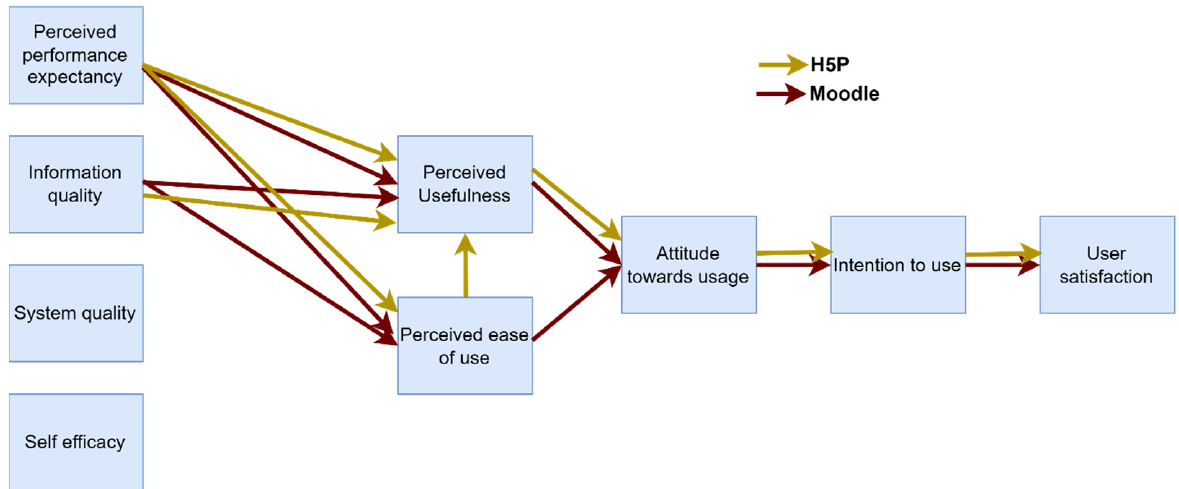
Figure 8. The factors influencing students’ satisfaction and use of the tool (Moodle and H5P).